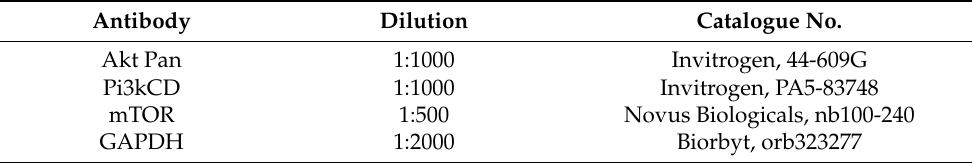
Table 2. List of antibodies employed for protein profiling using western blot analysis. Antibody Dilution Catalogue